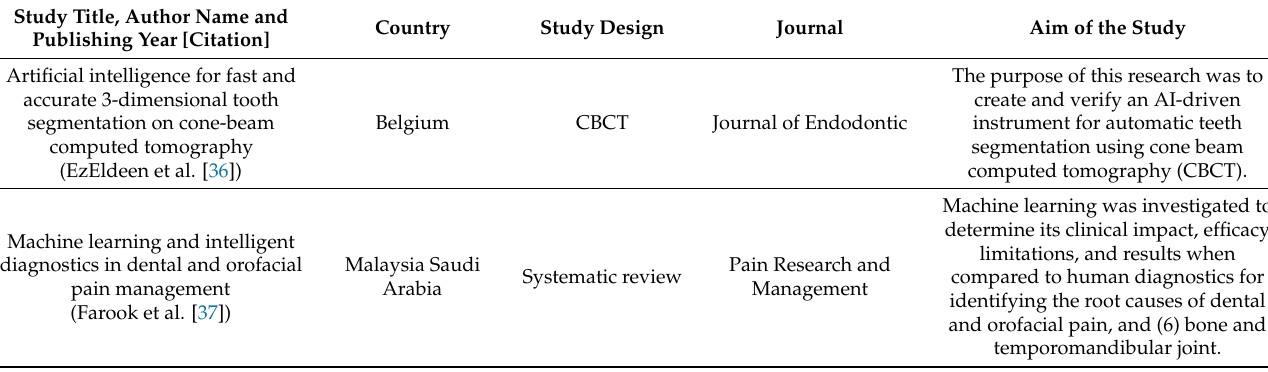
Table 1. Description of the study